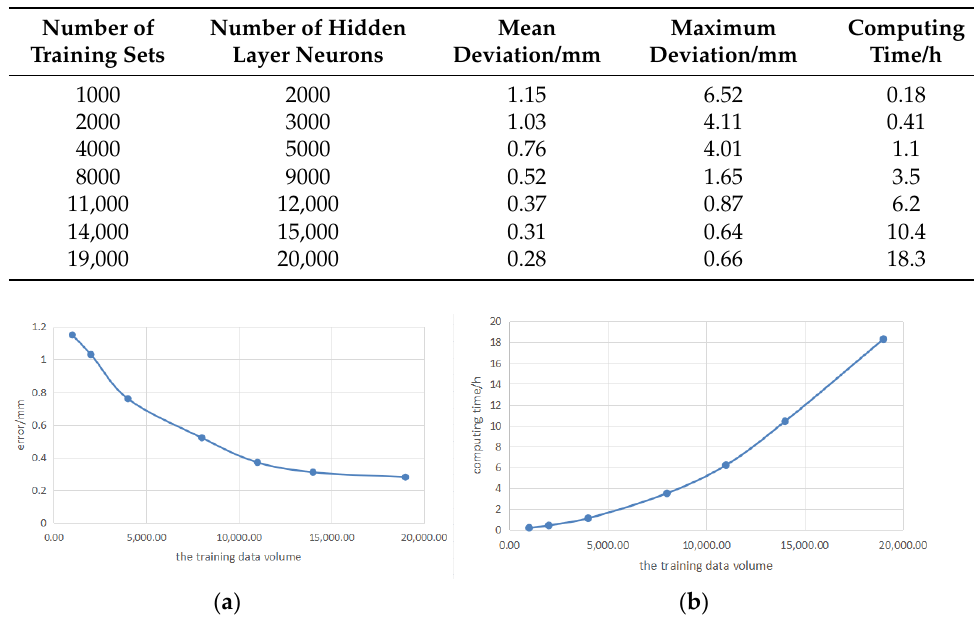
Table 1. Average and maximum deviations of calibration under different training set data volumes.